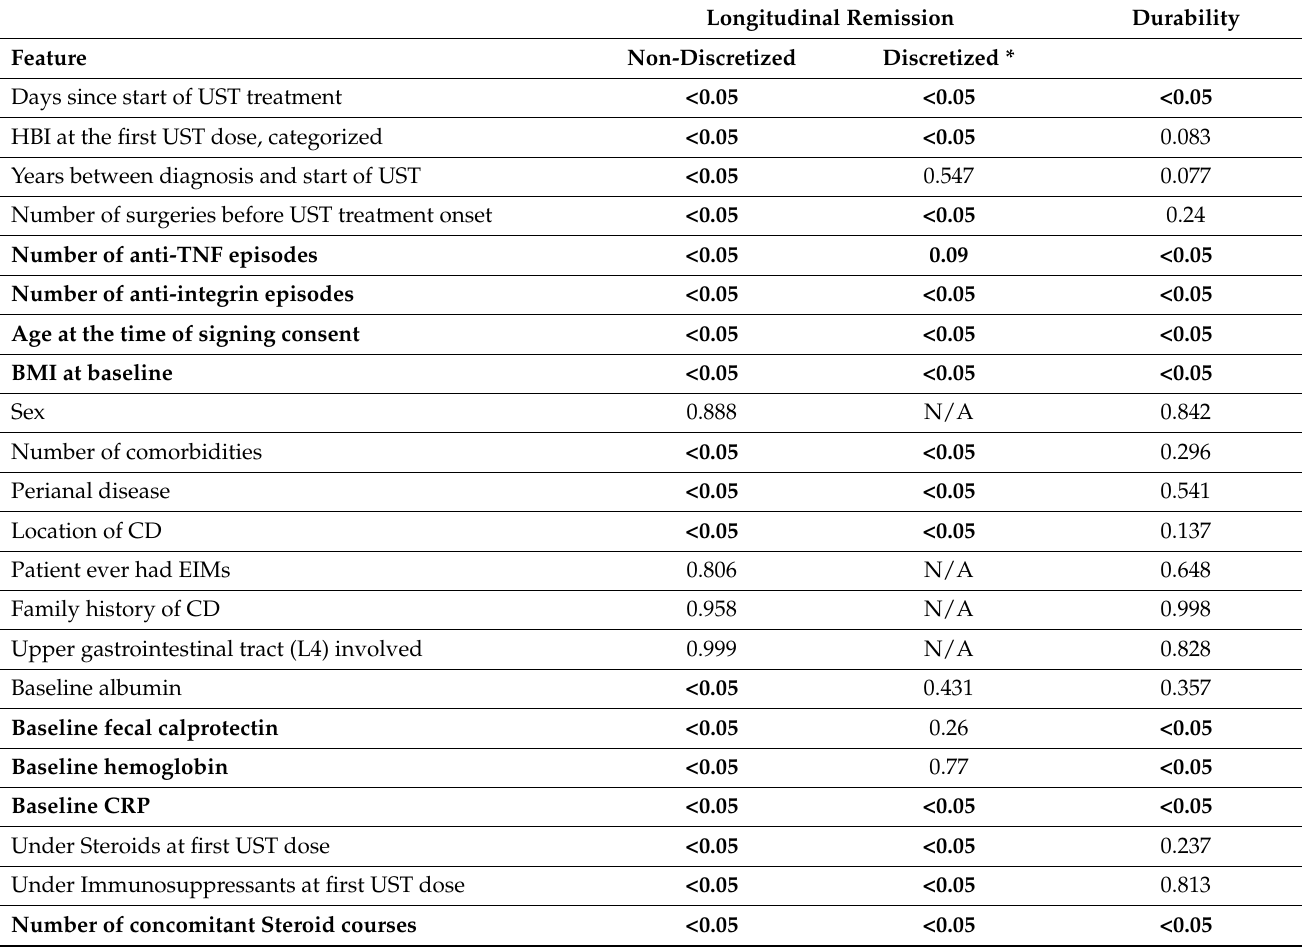
Table 2. Statistical significance ( p -value) of the effect of each variable in longitudinal remission and